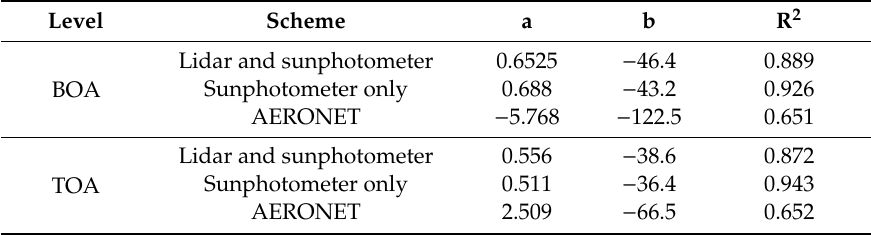
Figure 8. Radiative forcing versus AOD @ 440 nm for the ( A ) BOA and ( B ) TOA of the di ff erent schemes and their linear fit. Table 4. Linear fit parameters and R-squared values for radiative forcing vs. AOD @ 440 nm corresponding to the fine and coarse modes of the di ff erent